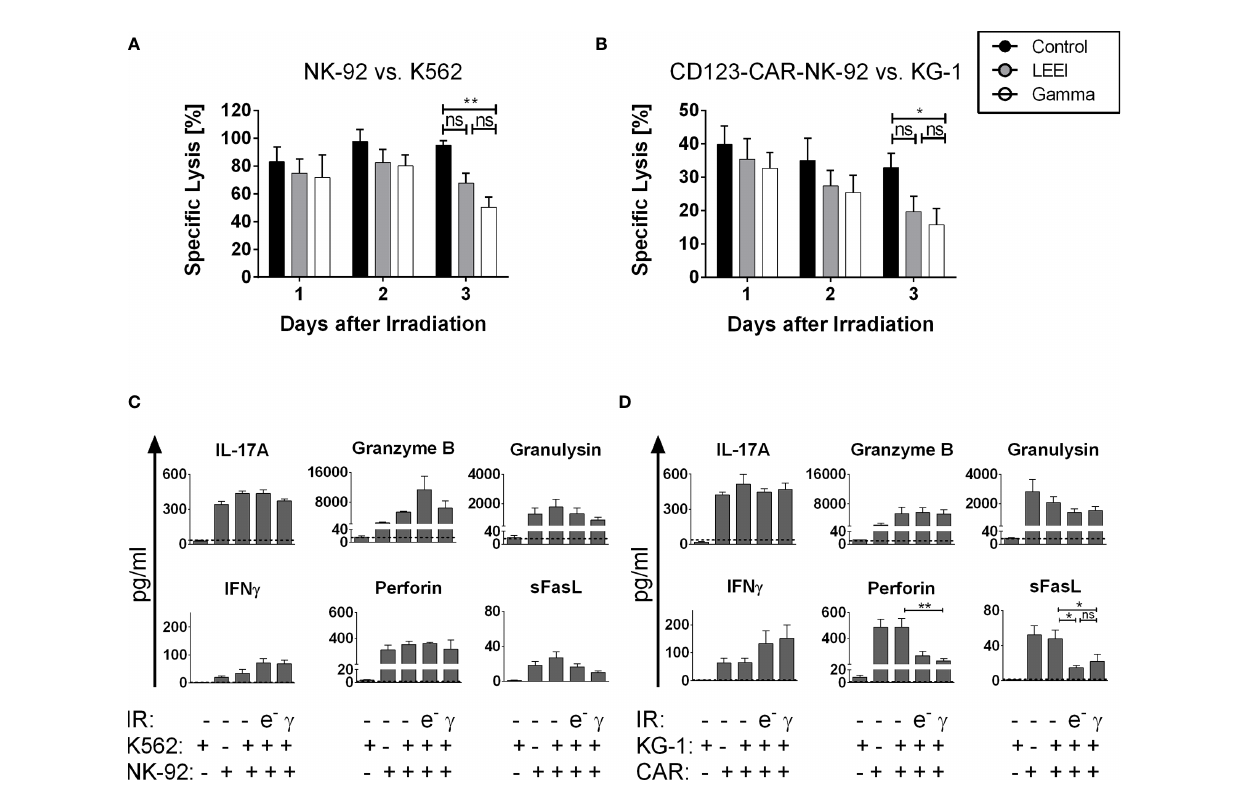
FIGURE 2 | LEE-irradiated cells show high in vitro functionality. (A+B): Cytotoxicity was measured via speci fi c lysis of K562 cells by NK-92 cells ( A , n = 5) or speci fi c lysis of KG-1 cells by CD123-CAR-NK-92 cells ( B , n = 9) by chromium-release-assay for 3 days after LEEI (grey) or gamma irradiation (white). Non-irradiated cells (black) were used as a control. Cells were coincubated at an effector to target (E:T)-ratio of 5:1. (C+D): Three days after LEEI or gamma irradiation, NK-92 ( C , n = 4) or CD123-CAR-NK-92 ( D , n = 7) cells were cocultivated with the target cell line K562 or KG-1 in an E:T ratio of 5:1 for 2 h, respectively. As controls, non-irradiated NK-92 or CD123-CAR-NK-92 cells with and without speci fi c target cell stimulation, and K562 and KG-1 cells alone were used. Supernatant was harvested and analyzed with a LEGENDplex human CD8/NK panel. Dotted line represents detection limit of this assay. Values are indicated as means ± SEM, statistical signi fi cance is symbolized by asterisks (ns for p > 0.05, * for p ≤ 0.05, ** for p ≤ 0.01, Kruskal-Wallis test adjusted for multiple comparisons by Dunn ’ s